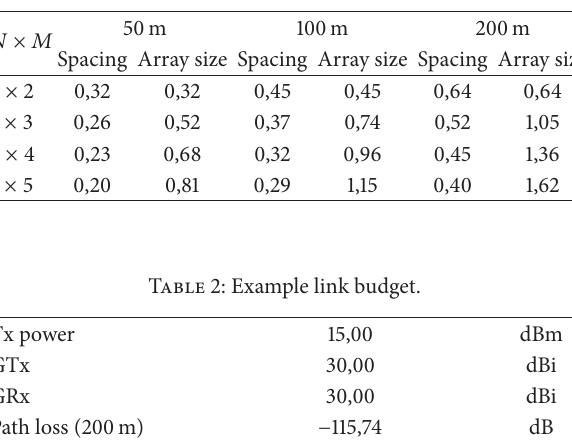
Table 1: MIMO element distances and array vertical size (in m) for the frequency of 73 GHz at different range.